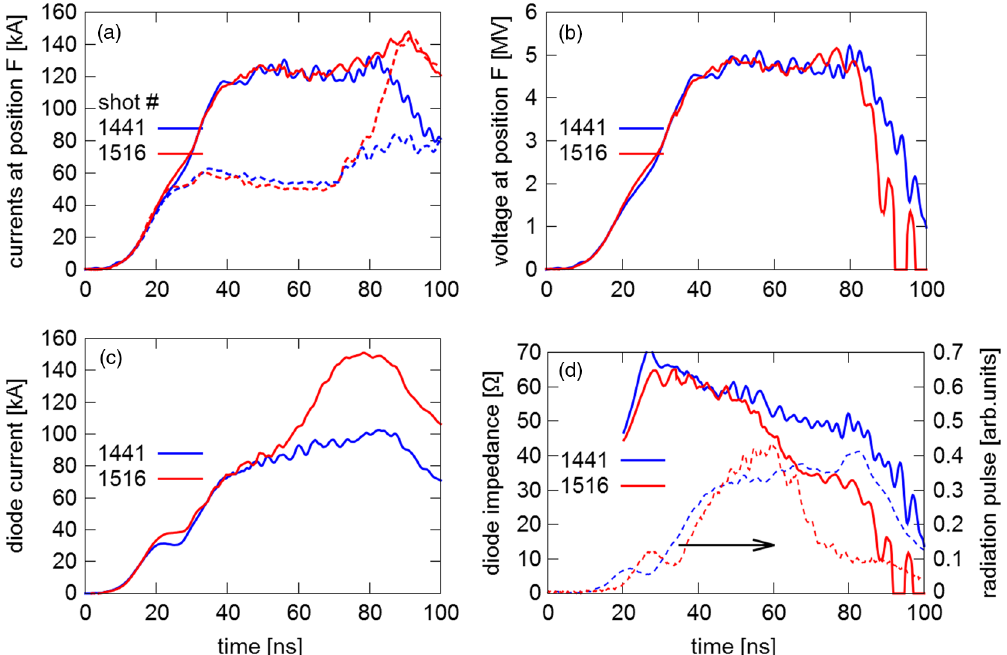
FIG. 2. Traces of the currents, voltage, diode impedance, and radiation pulse for two SMP diode shots with a 7-mm diameter cathode needle and a 7-mm AK gap. Shot 1441 (blue) demonstrates the desired diode behavior while Shot 1516 (red) has a premature radiation pulse termination due to a rapid drop in diode impedance. The IF (dashed) and OF (solid) currents are show in (a). The voltage at position F is shown in (b). The diode current is shown in (c). The diode impedance (solid) and radiation pulse (dashed) are shown in